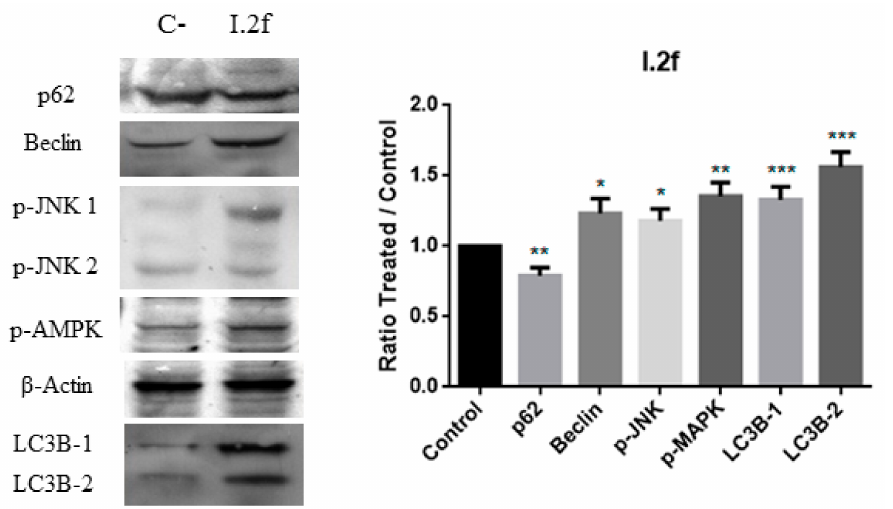
Figure 11. Western blot analysis of autophagy markers SQSTM1/p62, Beclin-1, p-JNKm p-AMPK and LC3B in MCF-7 cell culture treated with I.2f. * Statistical significance with values of p < 0.05; ** statistical significance with values of p < 0.01; *** statistical significance with values of p < 0.001. Bax is an important proapoptotic protein implicated in apoptosis induction. On the contrary, Bcl-2 is an important antiapoptotic protein that suppresses apoptosis. The balance between Bax and Bcl-2 is very important for judgmental cell apoptosis [41]. The II.2d (Figure 12). Significantly increased levels of BAX, p21, p53 and decreased levels of